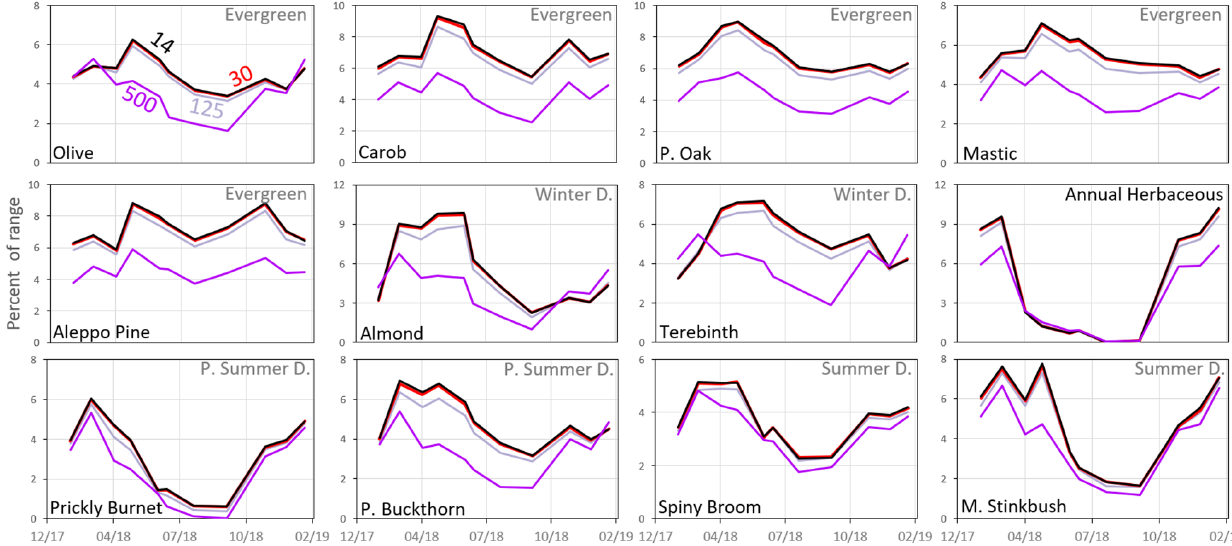
Figure 8. Standardized mean ExG values for the 12 species based on the UAV data (11 dates) after resampling to spatial resolutions of 14, 30, 125, and 500 cm. The y -axis represents the index mean value as a percent of the range of the possible values for each sensor.